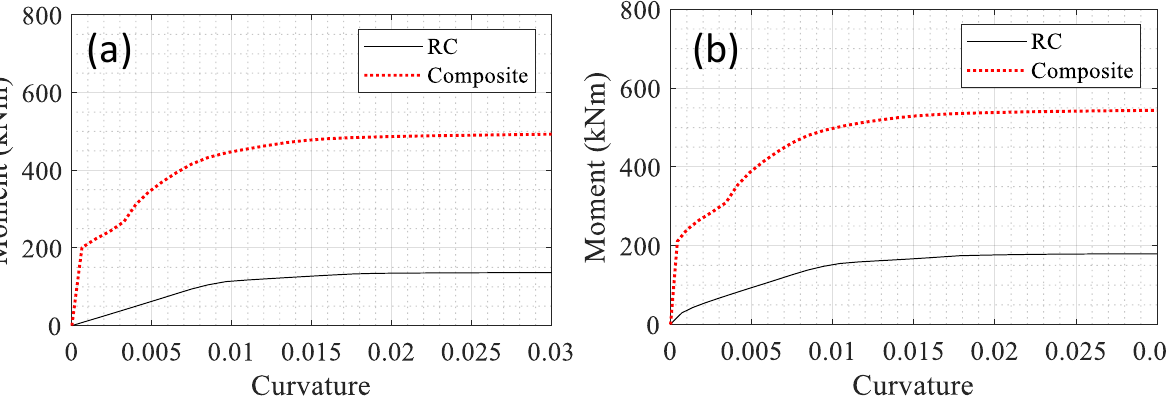
Figure 10. Comparison of the moment-curvature diagrams for the two sections under ( a ) no axial load and ( b ) under 5% axial load.